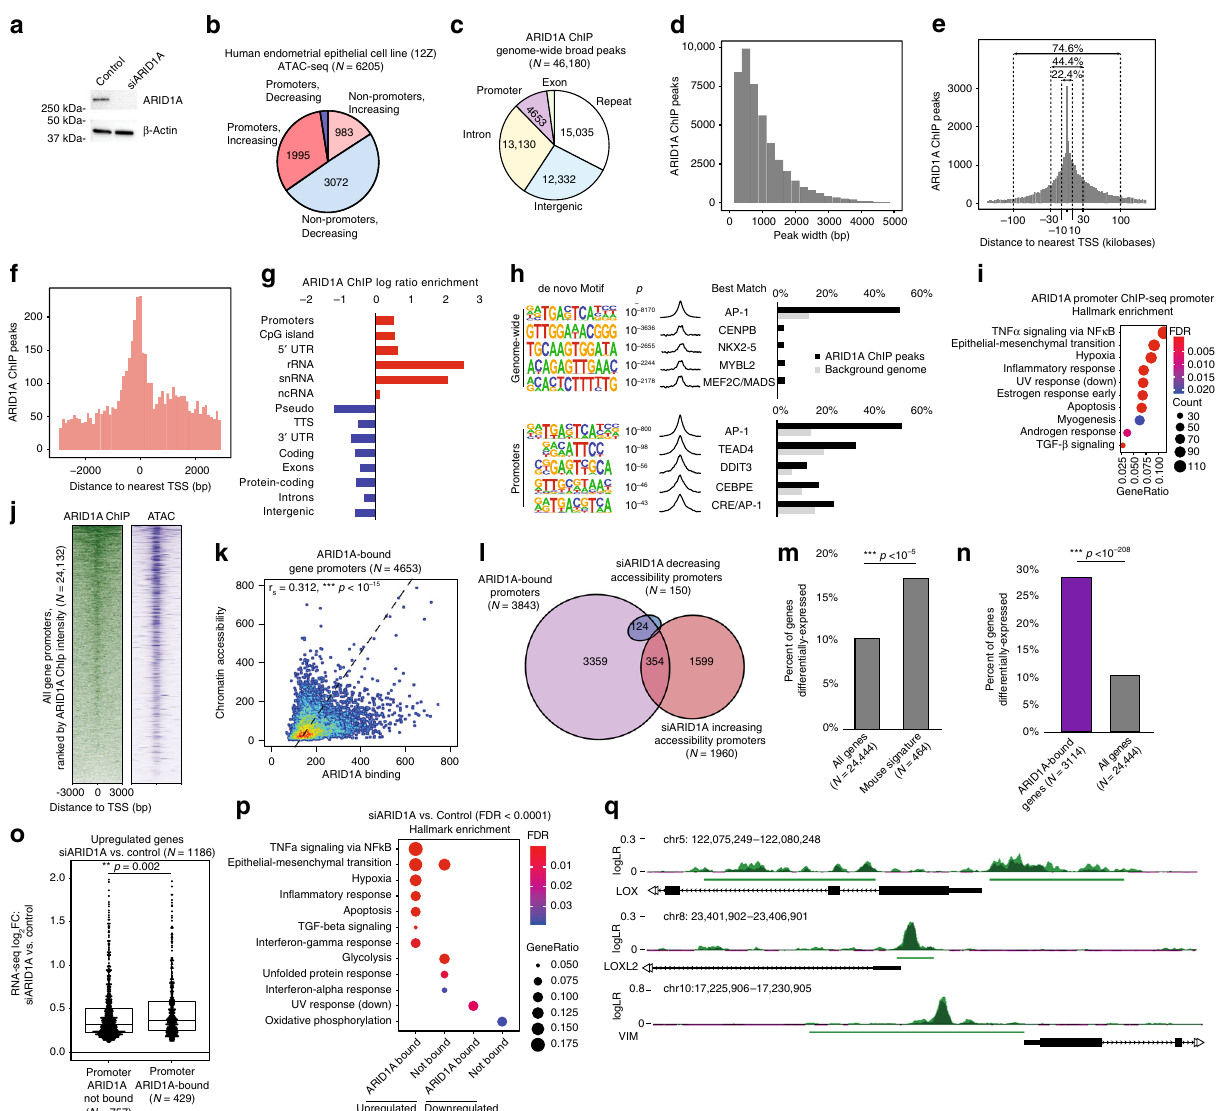
Fig. 5 ARID1A binding is associated with accessibility and differential gene expression driven by ARID1A loss in human endometrial epithelial cell line. a Western blot of ARID1A expression in siRNA-treated 12Z cells. β -Actin was used as endogenous control. b Annotation of differentially accessible ATAC peaks (FDR < 0.05) from 12Z siARID1A, separated into fractions by directionality and promoter vs. non-promoter. Signi fi cant association ( p < 10 − 500 , Chi- squared) between increasing accessibility and promoter status. c Annotation of ARID1A ChIP peaks in wild-type 12Z cells. d Peak width distribution of ChIP peaks. e Histogram of all ChIP peaks depicting distance to nearest TSS. Percent of peaks found within + / − 10, 30, or 100 kb of the TSS are shown. f Histogram of ChIP promoter peaks depicting distance to nearest TSS. g Enrichment for signi fi cant genomic features among ChIP peaks, ranked by p -value. Enrichment ratio is calculated by bp of feature in ChIP peak set compared to background genome. h de novo Motif enrichment of ChIP peaks genome-wide and at promoters. i mSigDb Hallmark pathway enrichment of genes with ChIP promoter peaks. j Read density heatmap of ARID1A ChIP-seq and ATAC-seq (control) at all gene promoters ( N = 24,132), ranked by signal intensity for ARID1A ChIP-seq. k Scatter plot depicting correlation between ARID1A binding and chromatin accessibility ( r s = 0.312, p < 10 – 15 , Spearman). l Proportional Euler diagram of overlap between ARID1A binding, decreasing and